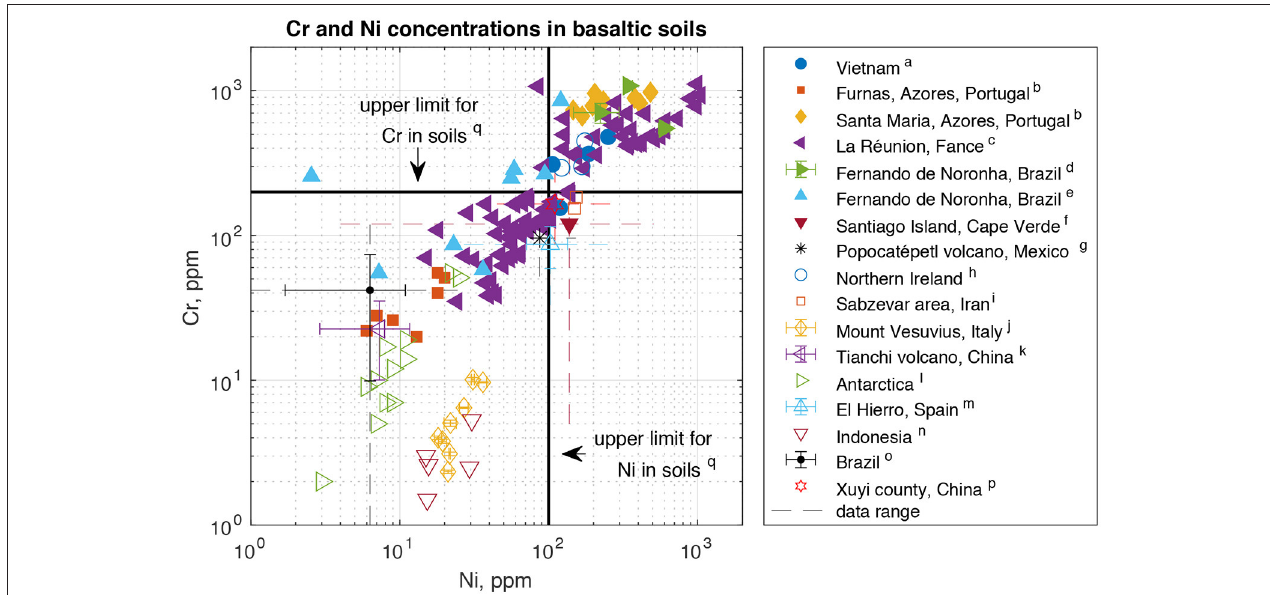
FIGURE 1 | Chromium and Ni concentrations in soils derived from basaltic rocks. The chosen acceptable limits for agricultural soils are representative of average limits throughout the EU ( Tóth et al., 2016), although both higher or lower values are adopted into legislature in various countries (Tóth et al., 2016; Iskandar et al., 2019). For studies where individual sample data were not reported, the mean as well as the range of results (stippled lines) are shown. Where reported, the standard deviation around the mean (error bars) is plotted as well. (a) Tra and Egashira, 2001, (b) Amaral et al., 2006, (c) Dœlsch et al., 2006a, (d) de Oliveira et al., 2011,